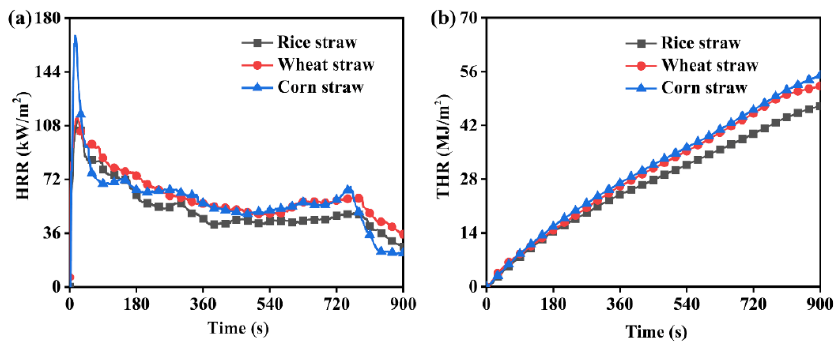
Figure 2. HRR curves ( a )and THR curves ( b ) of the three crop straws at 50 kW/m 2 . Table 3. Results of the cone calorimeter test.